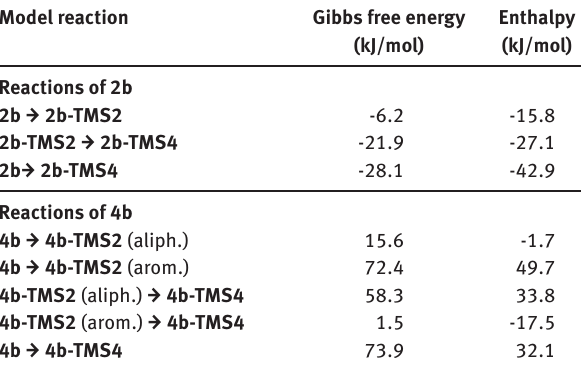
Table 10: Calculated Gibbs free energies and enthalpies for the silylation reactions of 2b and 4b with HMDS, calculated at the M062X/6-31G(d) level in THF solution with the PCM model Model